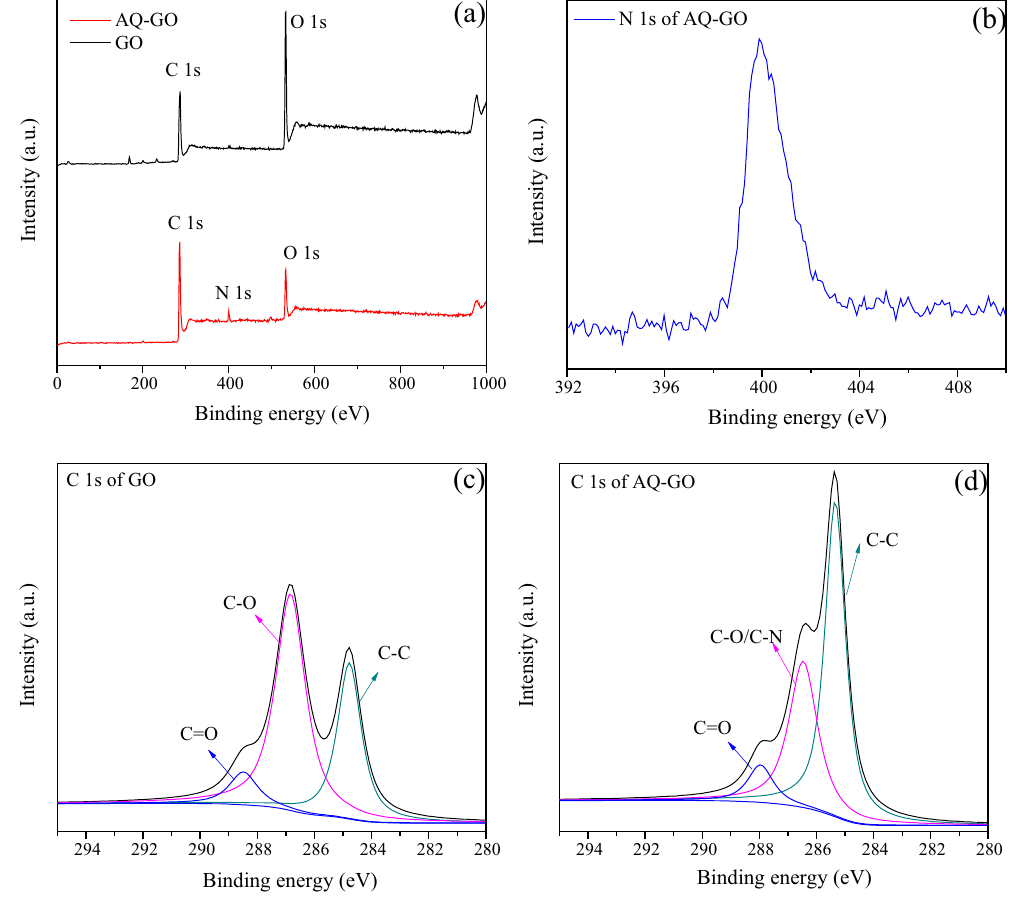
Figure 1. XPS spectra of GO, AQ-GO ( a ), N 1s of AQ-GO ( b ), C 1s of GO ( c ) and C 1s of AQ-GO ( d